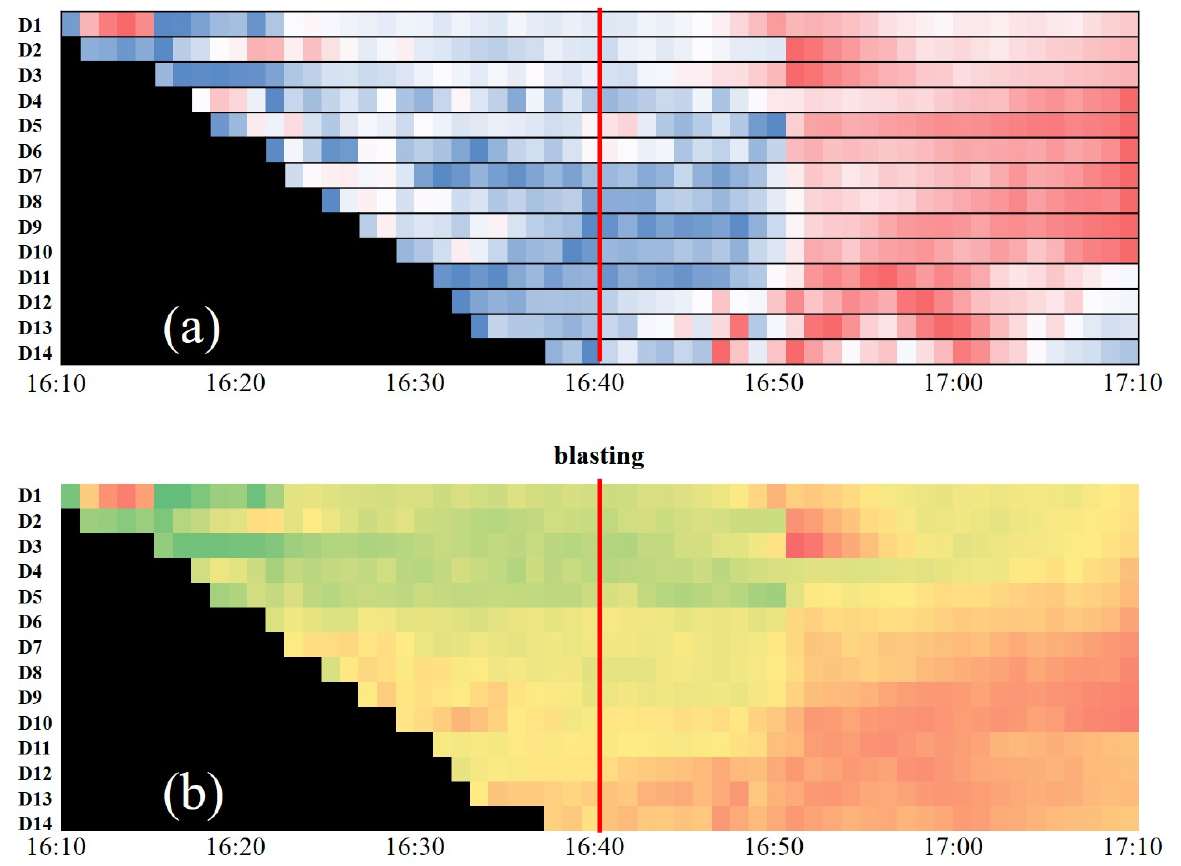
Figure 8. Measurement result of dust density. ( a ) Dust density change of each module and ( b ) distribution of overall dust density.